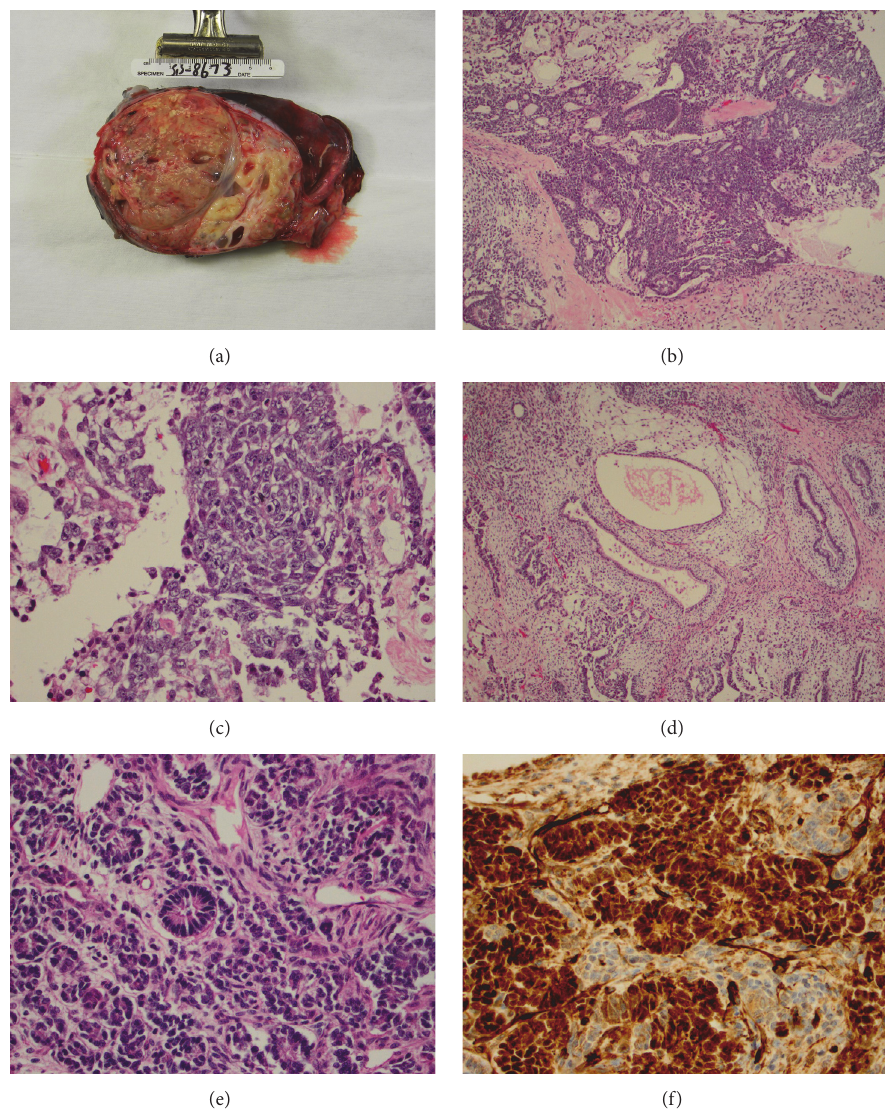
Figure 2: (a) Encapsulated solid mass with interspersed cystic areas. Yolk sac tumor component (b), embryonal carcinoma component (c), and teratoma component (d) were identified. (e) Nephroblastoma component shows typical blastema and epithelial components. (f) Nephroblastoma component has strong WT-1